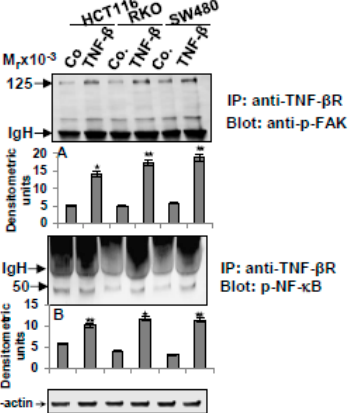
Figure 6. Association of TNF- β R proteins with focal adhesion kinase (FAK) or NF- κ B in CRC cells. CRC cells were untreated (Co) or treated with TNF- β (10ng/mL) in suspension for 10 min, and then transferred to the alginate beads for three days. Whole cell lysates were immunoprecipitated (IP) with anti-TNF- β R. Finally, the immunoprecipitates were separated by SDS-PAGE and analyzed by immunoblotting (IB), using anti-p-FAK ( A ) and anti-p-NF- κ B ( B ). Densitometric assessment of protein expression, as shown by immunoblotting, was done in triplicate. The original extracts were tested with an antibody to β -actin, as a loading control. Data were compared with the control and statistically significant data with p < 0.05 were designated an asterisk (*) and p < 0.01 were designated two asterisks (**). IgH = immunoglobulin heavy